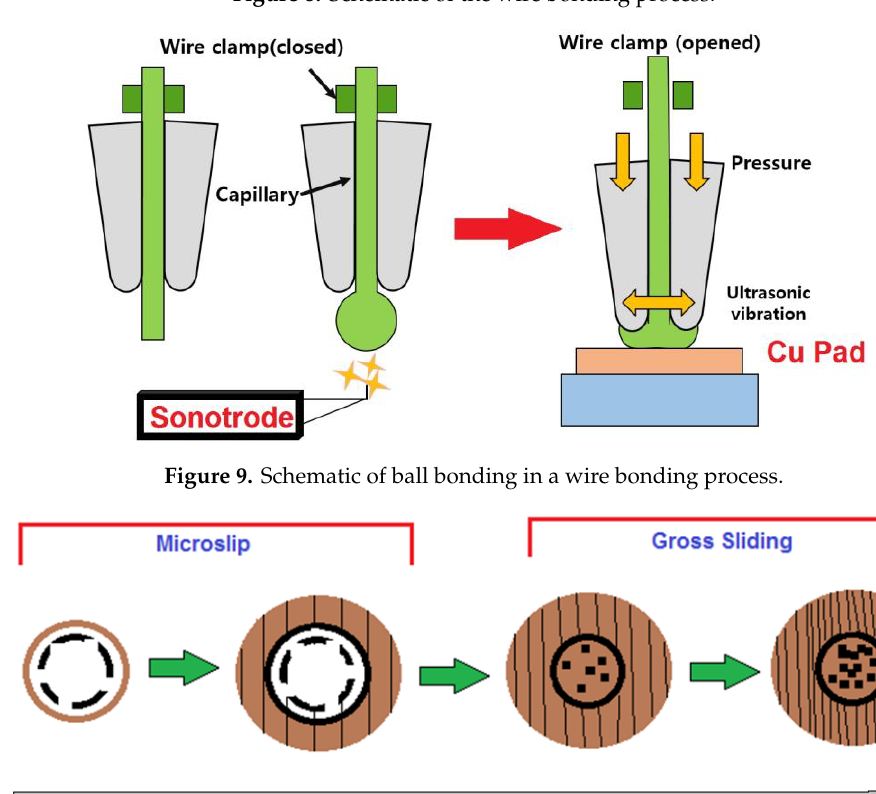
Figure 9. Schematic of ball bonding in a wire bonding process.